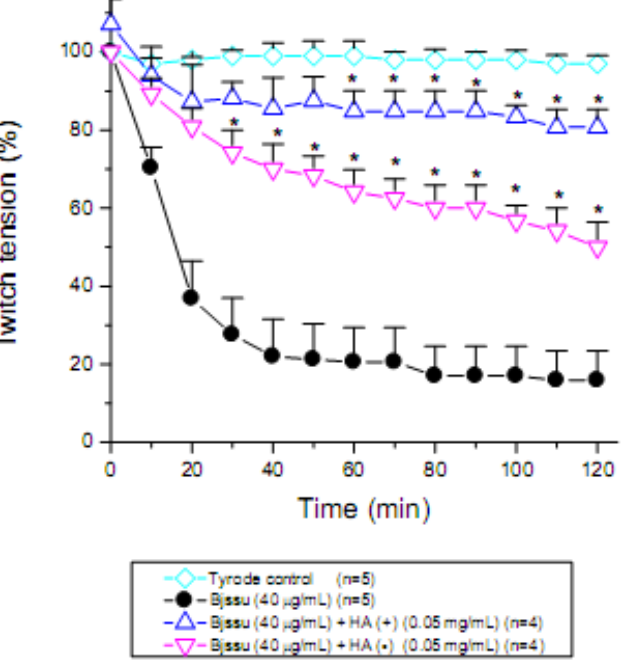
Figure 2. Pharmacological assays to determine the effect of tannin in the hydroalcoholic (HA) extract of D. alata barks on mouse phrenic nerve-diaphragm preparations stimulated indirectly. Note that both the extract containing tannin  HA(+)  and the extract free of tannin  HA(-)  significantly improved the muscle twitch tension and hence decreased neuromuscular blockade promoted by Bothrops jararacussu (Bjssu) venom alone. However, HA(+) showed more efficicacy than HA (-). Each point represents the mean ± S.E.M. of the number of experiments (n) showed in the legend. *p < 0.05 compared to